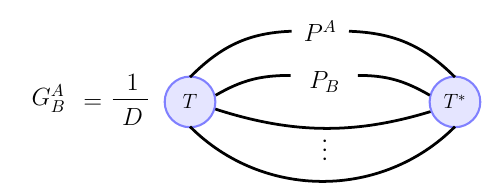
Figure 11. Illustration of equation (6.5).